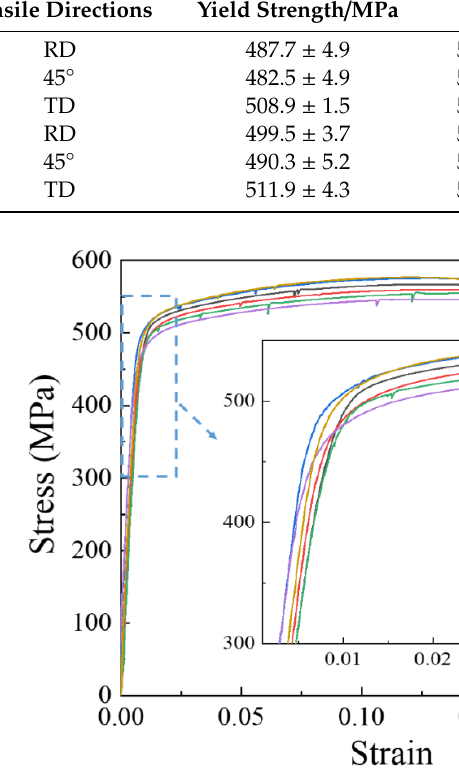
Figure 12. The tensile curves of the FH and SH samples after artificial aging (T6).